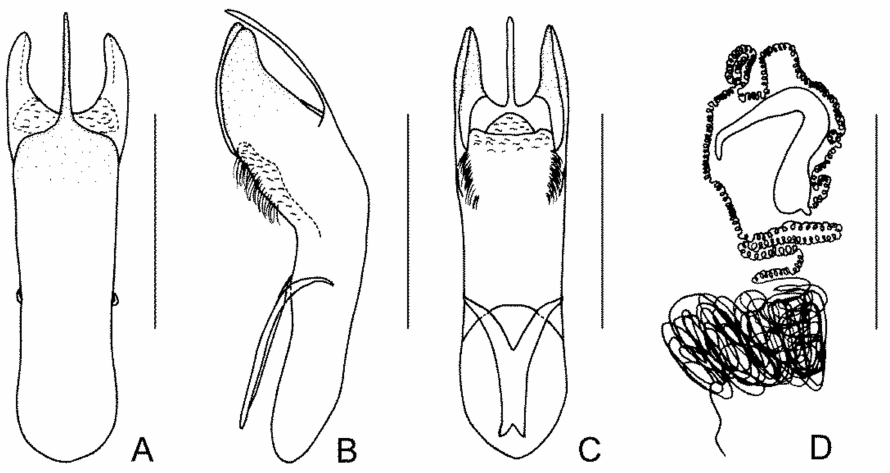
Figure 30. Cryptocephalus ( Burlinius ) pusus Schöller, 2009: ( A ) dorsal view of aedeagus; ( B ) lateral view of aedeagus; ( C ) ventral view of aedeagus; ( D ) spermatheca. (Scale bars: 0.5 mm). Schöller, 2009: 106 (replacement name of Cryptocephalus nanus ); Lopatin et al., 2010: 599 (subg. Cryptocephalus )